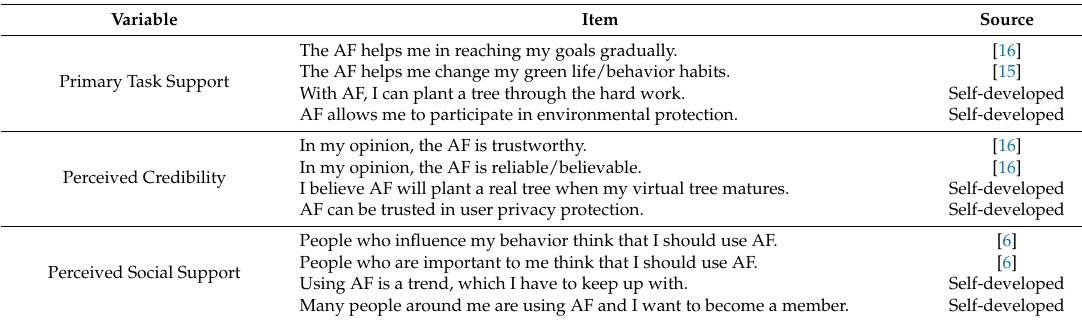
Table 1. Measurement items and